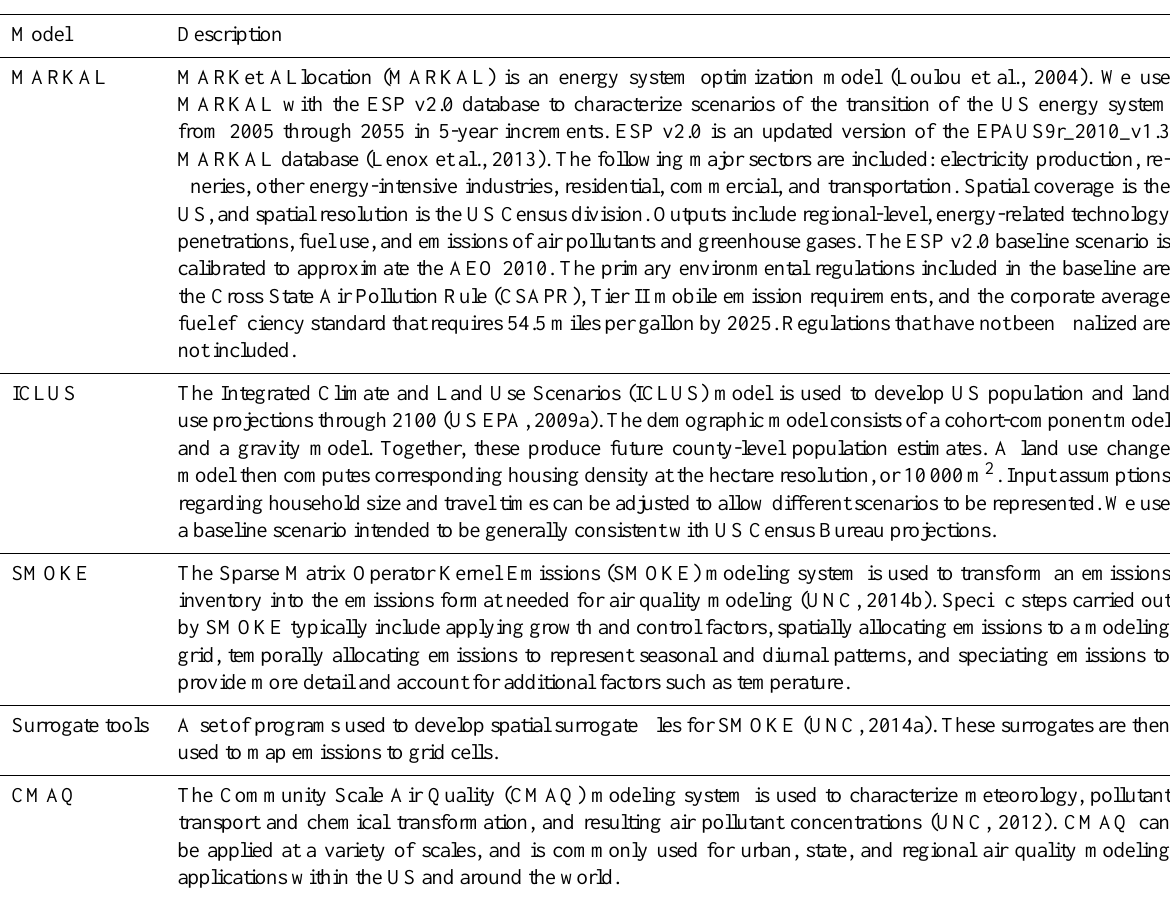
Table 1. Models used in the ESP v2.0